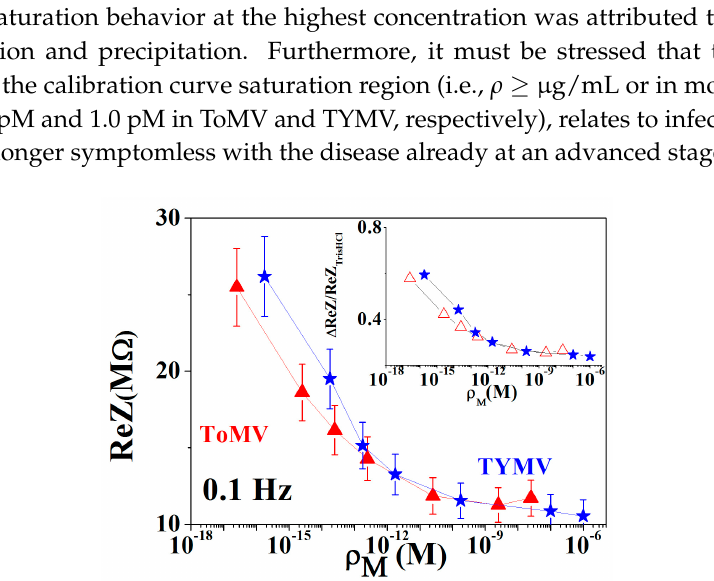
Figure 4. Calibration curves for virus quantification represented as ReZ at 0.1 Hz vs. the molar virus concentration in the droplet suspension. The inset represents the relative variation of the ReZ values respect to the blank TRIS-HCl.